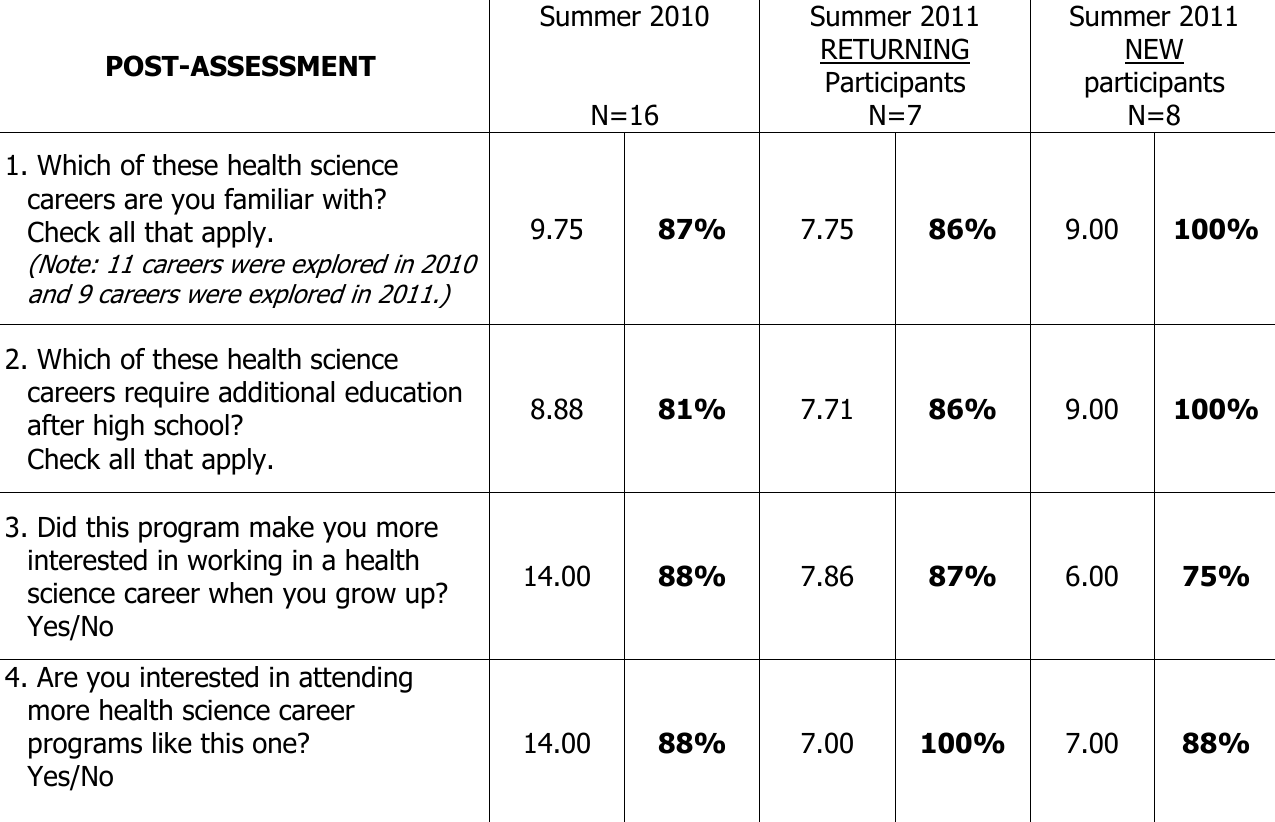
Analysis of 2010 and 2011 Health Science Explorations summer session post-assessment